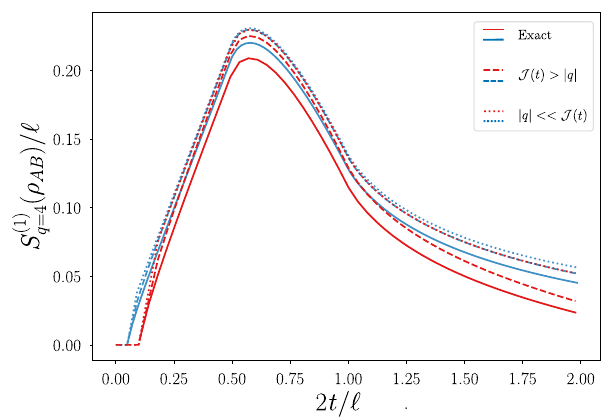
FIG. 3. The SROE in the scaling limit: a comparison between the analytical expression in Eq. (45) (solid line) and its asymp- totic approximation in Eqs. (46) (long-dashed line) and (47) (short-dashed line). Here, q = 4 and (cid:5) = (cid:5) A + (cid:5) B with (cid:5) A = (cid:5) B ; the blue line corresponds to (cid:5) = 256, while the red ones to (cid:5) =